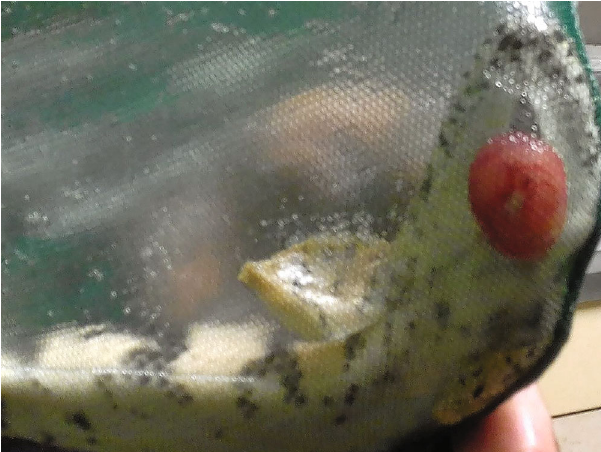
Figure 2: Firm, spherical, centrally ulcerated mass in the gular region of a saddled bichir ( Polypterus endlicheri endlicheri ) on clinical presentation, 1 week after fi rst observation. The mass emerges from tissue deep to the axial margins of gular plates, pushing the plate margins